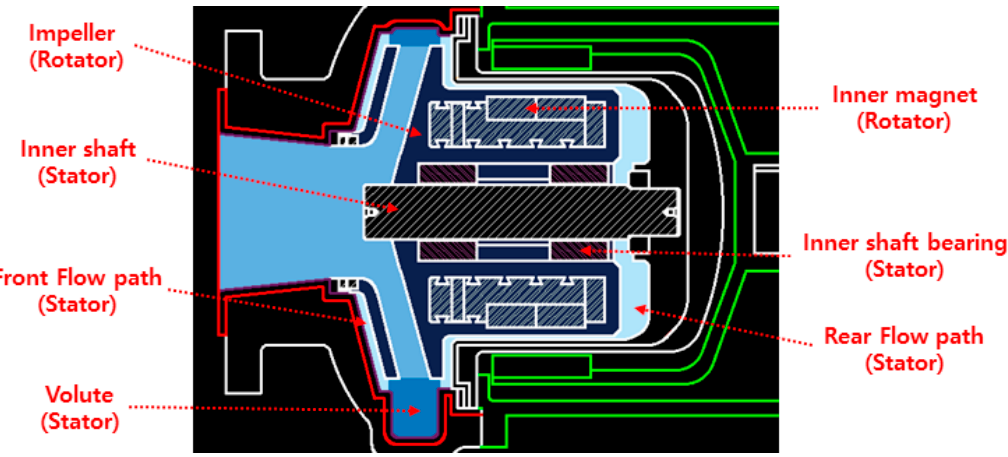
Figure 1. 2D cross section of the magnetic drive pump.